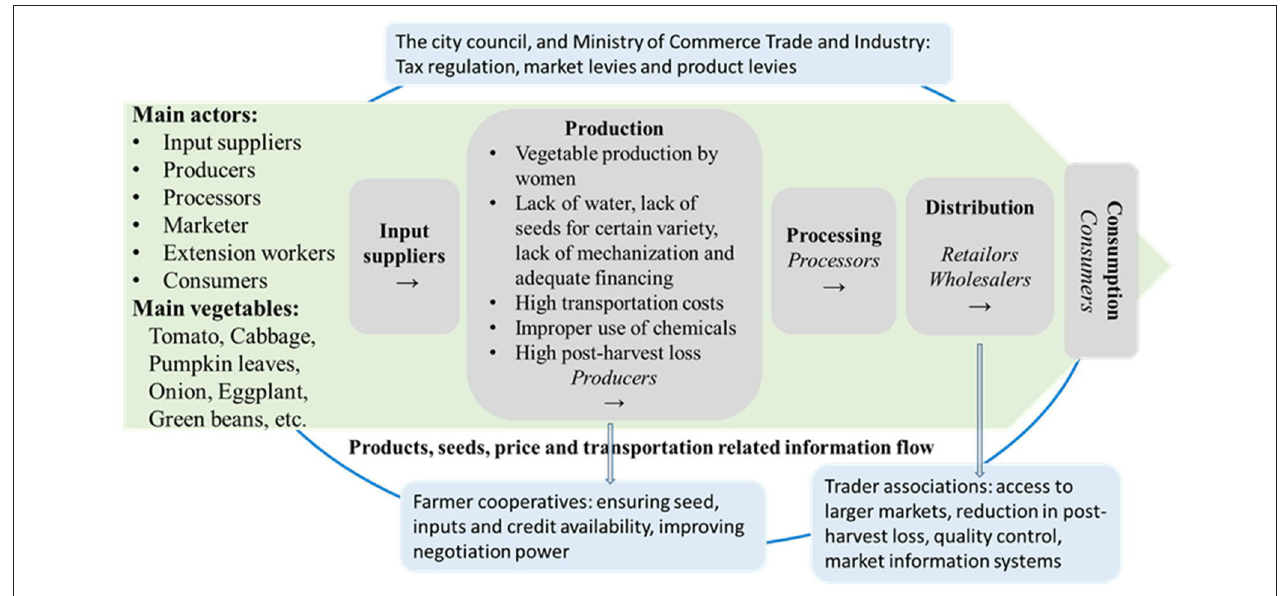
FIGURE 2 | The status quo of vegetables value chain in Chongwe.